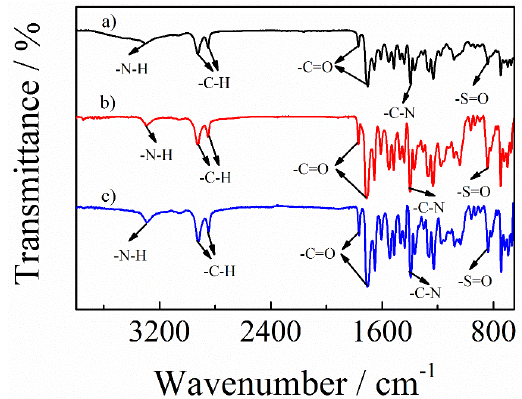
Figure 9. Fourier transform infrared spectroscopy (FTIR) spectra of PAI (black), PAI/PANI binary (red line), and PAI/PANI/CB ternary composite with a weight ratio of 10 wt% CB (blue line).